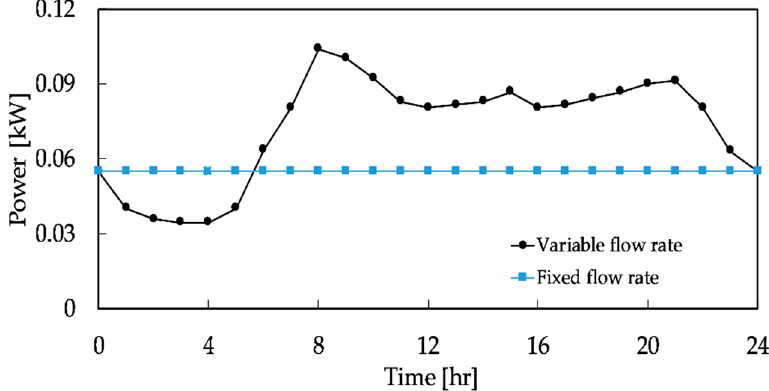
Figure 16. Power in the fixed and variable demand patterns.